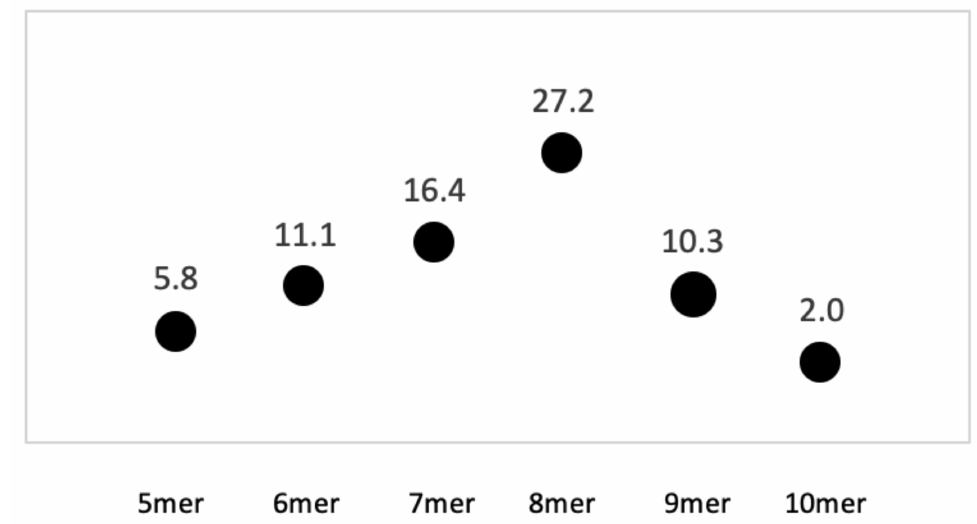
Figure 2. Ratios of AT homopolymers from 5 to 10 nucleotides in Salmonella enterica serovar Ty- phimurium LT2 NC_003197.2. The ratio of AT homopolymer kmers, either adenine or thymine but not mixed, to GC homopolymers was determined using Geneious software as described in text. The range in number of nucleotides per kmer searched was 5 to 10 (see legend label). Results show that a nucleotide motif of 8 was the most commonly encountered, and that approximately 27 AT homopolymers were found for every 1 GC AT homopolymer in the reference sequence of S. enterica LT2